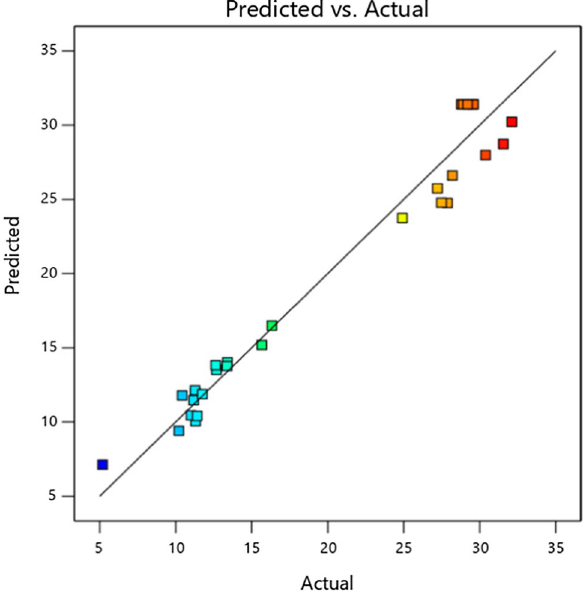
Fig. 19 Predicted vs. actual plot for Q a bar graph. The value of desirability fluctuates from 0 to 1 depending on how close the response is to the goal. The bar graph depicts the appropriateness of each process variable to the design criterion, with values around one indicating good suitability.